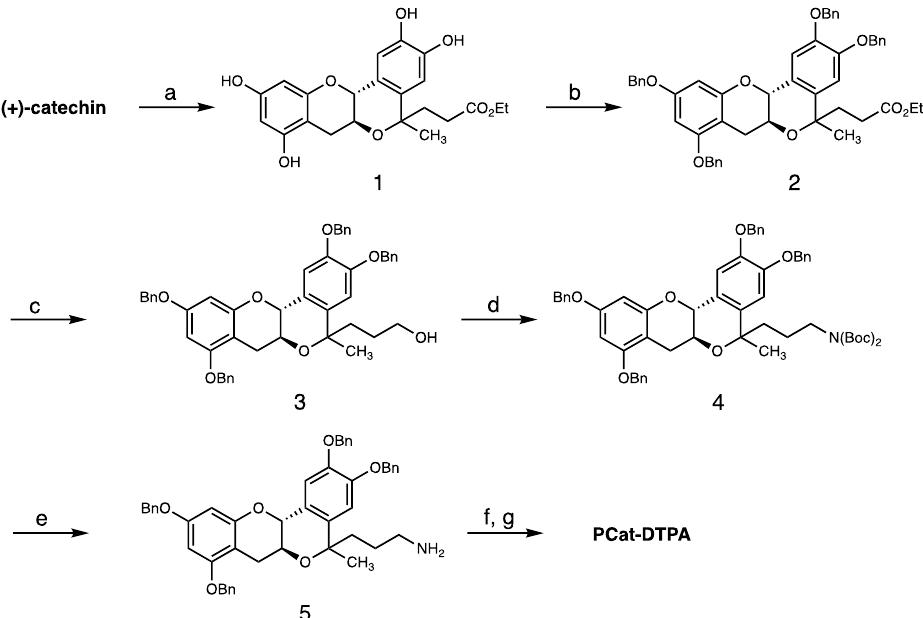
Figure 2. Synthesis of PCat-DTPA. Reagents and conditions: (a) 4-oxovalerate, TMSOTf, THF, − 20 ◦ C; (b) benzyl bromide, K 2 CO 3 , DMF, rt; (c) LiAlH 4 , THF, rt; (d) di- tert -butyliminodicarboxylate, Ph 3 P, DEAD, toluene, 0 ◦ C; (e) TFA, rt; (f) DTPA, DMT-MM, DMSO, rt; (g) 20% Pd(OH) 2 , H 2 , MeOH,